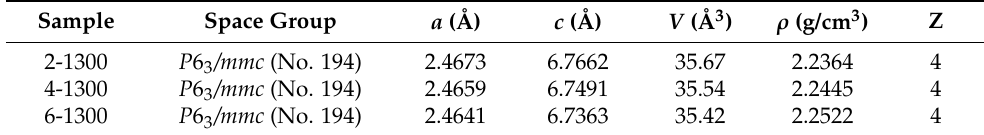
Figure 1. XRD patterns of lignite samples treated at ( a ) 2 GPa in the temperature range from 20 to 1300 °C, ( b ) 4 GPa in the temperature range from 20 to 1300 °C, and ( c ) 6 GPa in the temperature range from 20 to 1300 °C. Table 1. Crystal cell data of samples.